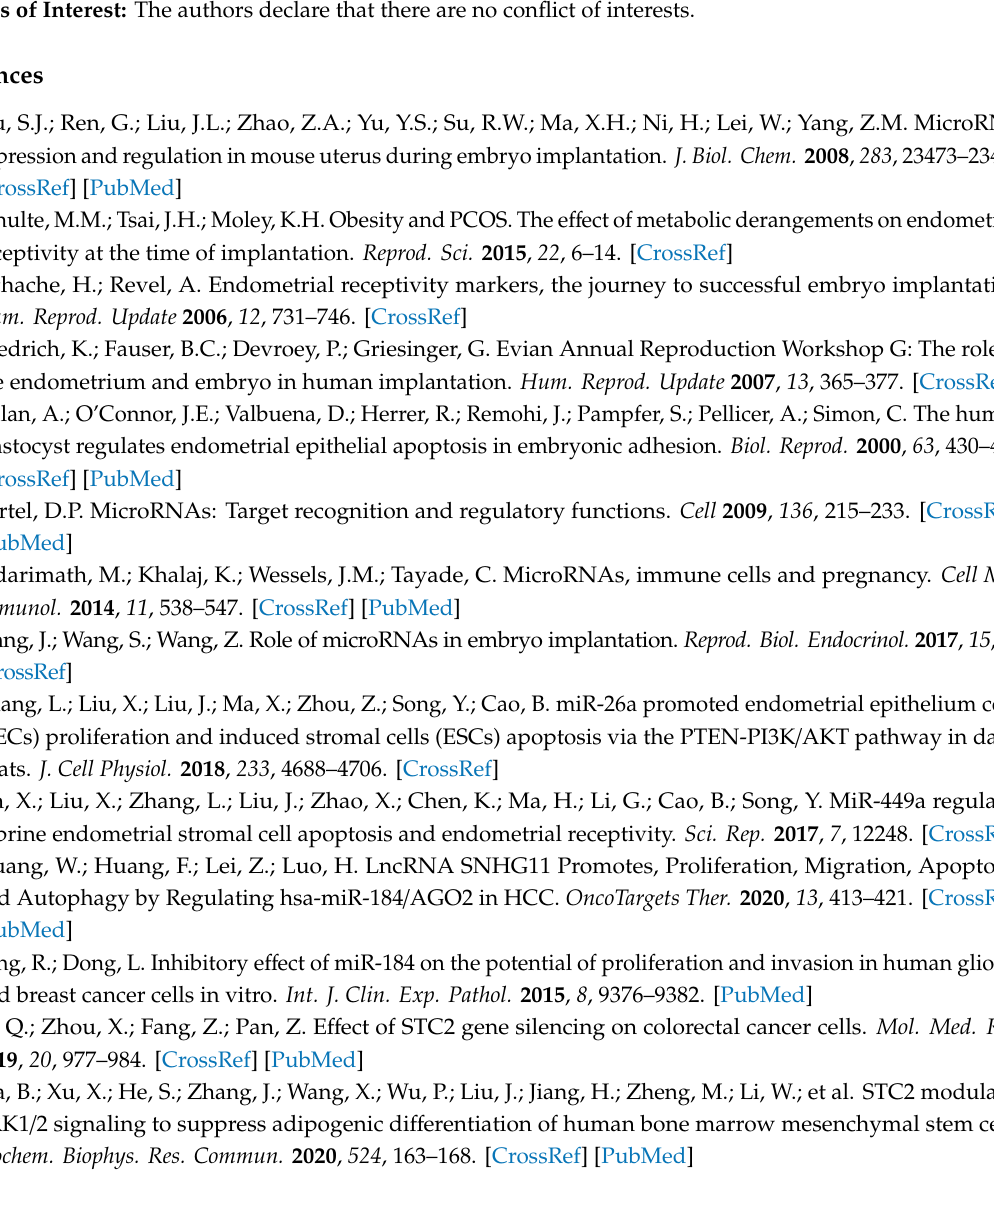
Figure S1: E ffi ciency of miR-184 transfection into EECs, Figure S2: MiR-184 promoted apoptosis of EECs, Figure S3: The transfection e ffi ciency of Si-STC2 and pc3.1-STC2 into EECs, Figure S4: STC2 inhibited apoptosis of